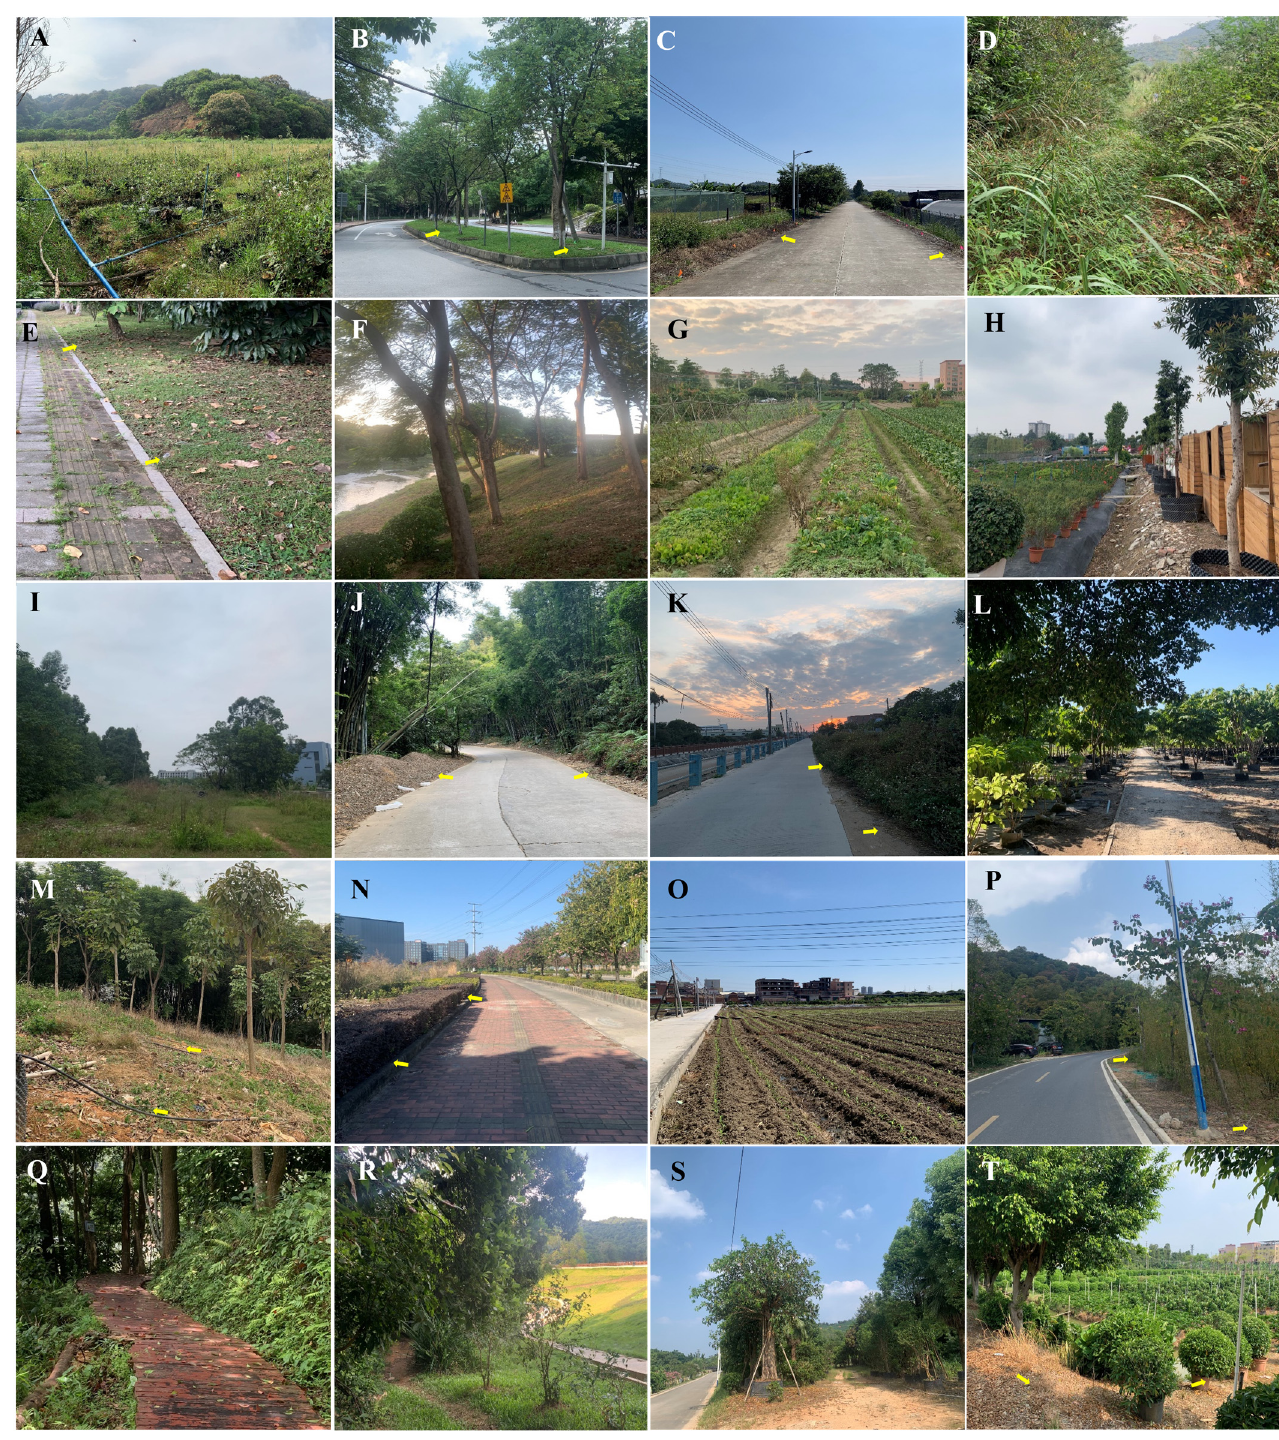
Figure 1. Picture of each experimental location. The yellow arrow indicates the site where bait, tape, or pitfall trap was set. ( A – T ) indicate location 1-20, respectively.